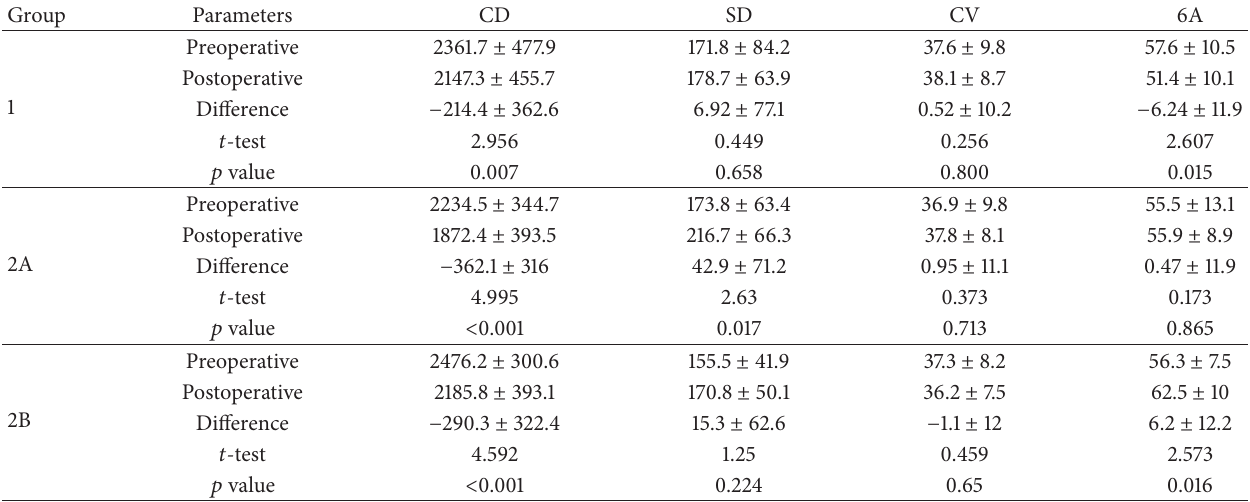
Table 2: Difference and statistical analysis between preoperative and postoperative parameters (mean ± standard deviation; CD: cell density; SD: standard deviation; CV: coefficient of variation; 6A = hexagonality coefficient).